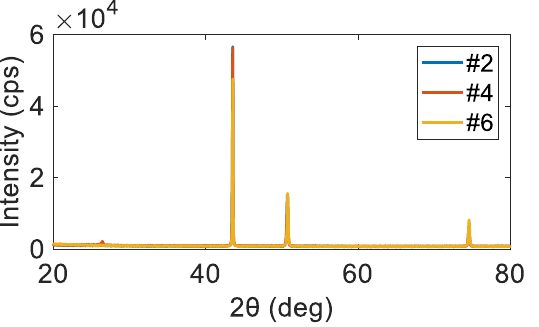
Figure 3. XRD results for the #2, #4, and #6 samples. The major phases with the highest peak intensities of the samples were presented as cubic FCC-austenite γ .